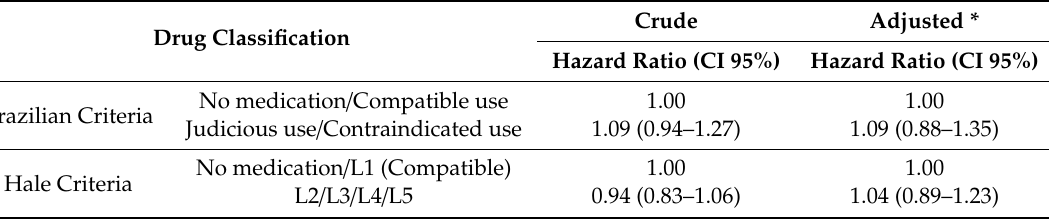
Table 3. Relationship between drug use during the first three months postpartum and weaning at 6 months (excluding women who weaned before 3 months), controlled for confounding variables, considering Hale’s lactation risk categories [16] and Brazilian Ministry of Health criteria [17]. Pelotas (Brazil) Birth Cohort Study, 2015.